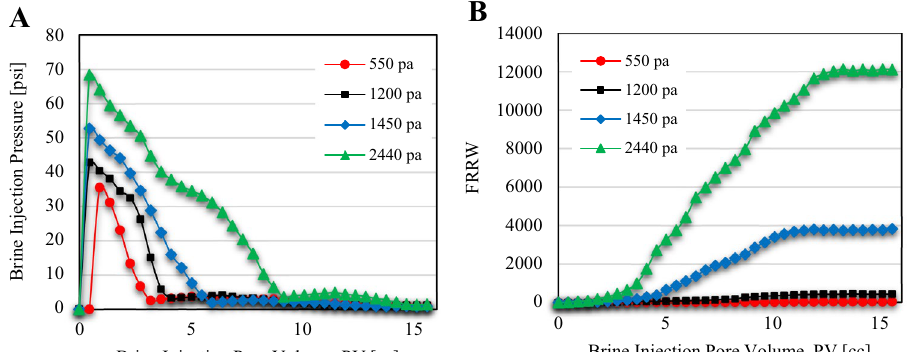
Fig. 11 a Brine injection pres- sure and b the Frrw (0.5 mm fracture